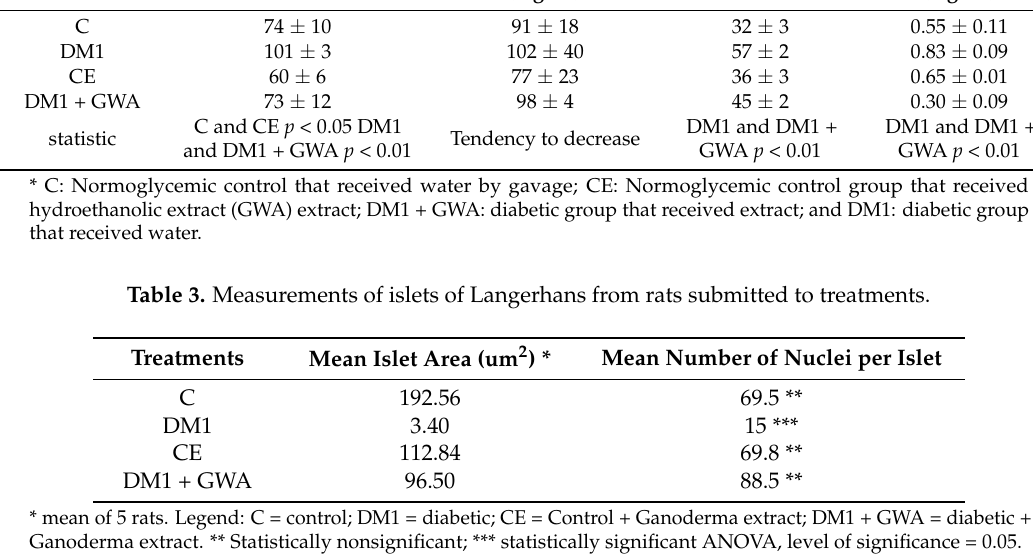
Table 2. Plasma biochemical analysis from rats submitted to treatments. Treatments * Total Cholesterol (mg/dL)